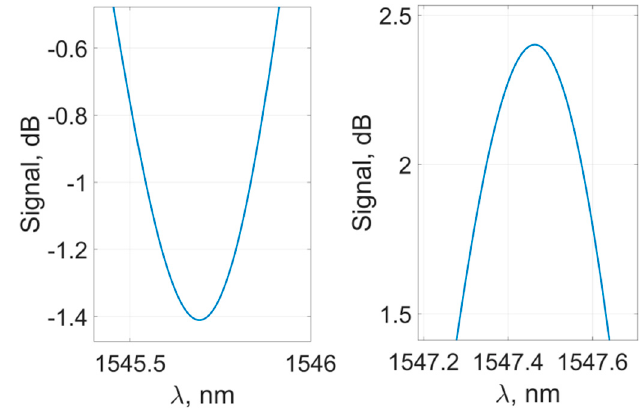
Sensors 2019 , 19 , x FOR PEER REVIEW